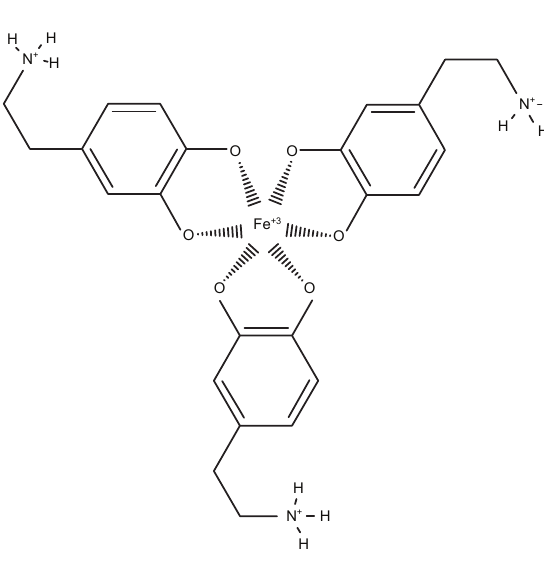
Figure 7. Proposed model for DA melanogenesis. To produce optimal formation of melanin, two factors are necessary: chelation and free-radical polymerization. Dopamine molecules chelate iron by the catechol group, positioning the DA molecules to allow for quick radical polymerization between the benzene rings, with block by radical scavenging antioxidants like ascorbate and GSH. The proposed model is that dopamine chelation of iron forms a dopamine aggregate around iron, bringing the benzene rings in close proximity to each other to allow for radical induced polymerization. While this may be the building block of neuromelanin, it should be noted that in vivo neuromelanin will include junk peptides, amino acids, and other biomolecules that will have been incorporated through proximity to radical